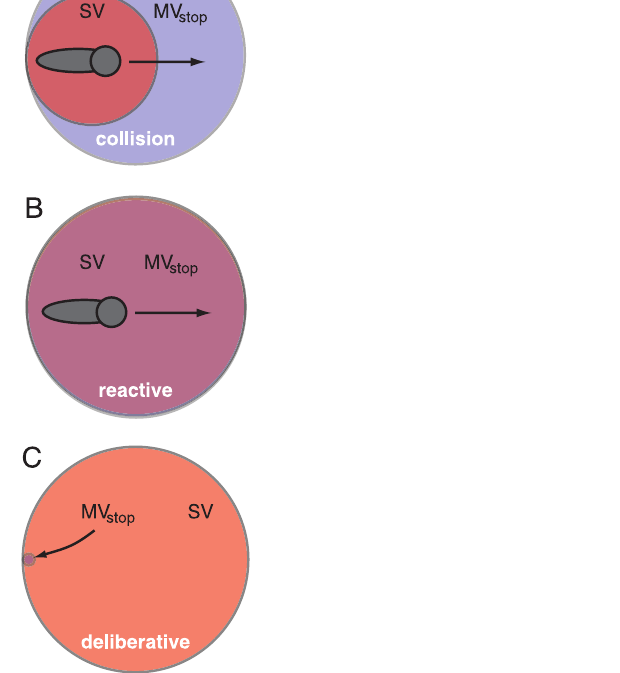
Figure 5. Sensory and Stopping Motor Volume Geometries (A) Collision mode: sensory volume (red) for the animal (gray) is smaller than the stopping motor volume (blue). (B) Reactive mode: sensory volume and stopping volume are equal. (C) Deliberative mode: sensory volume is much larger than the stopping